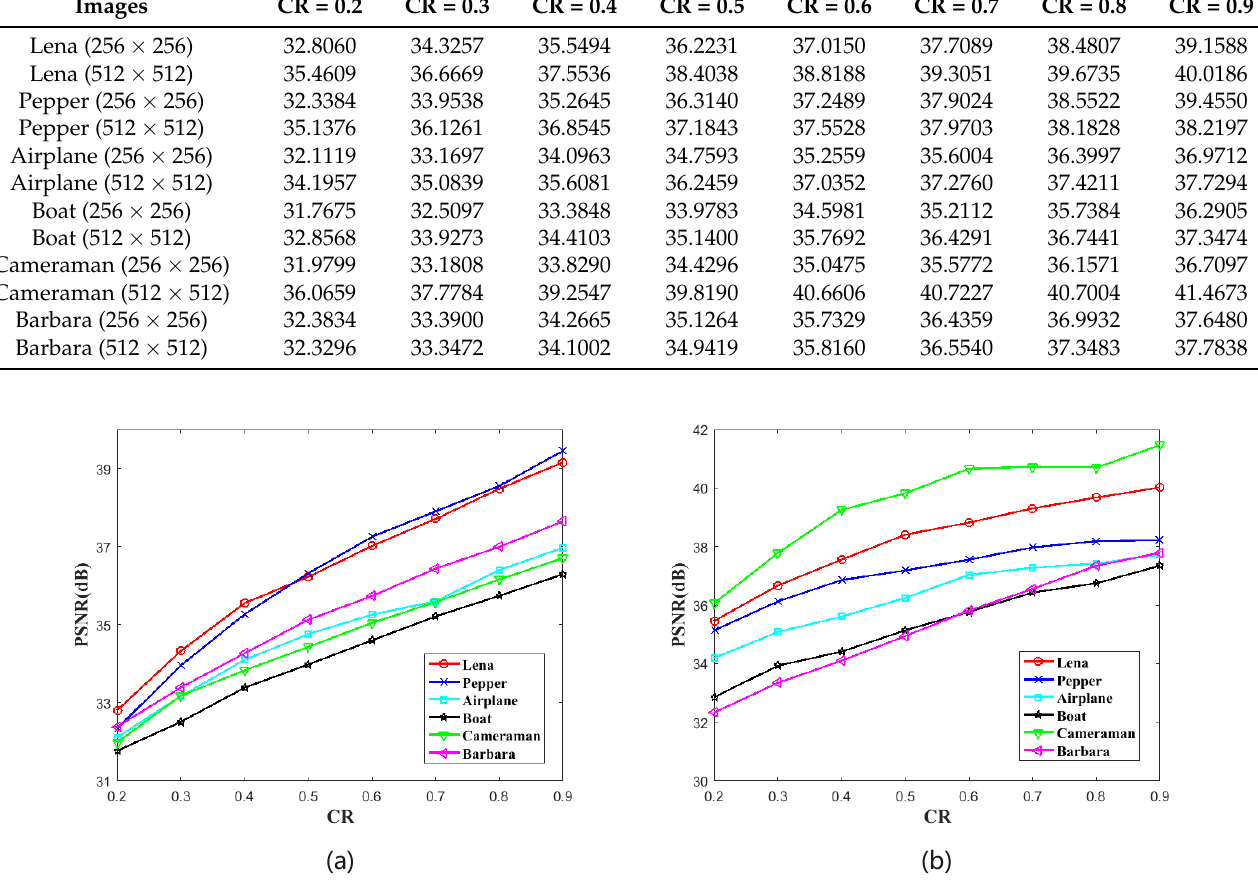
Figure 4. The Peak Signal to Noise Ratio (PSNR) test result. ( a ) shows the results of images with the size of 256 × 256. ( b ) shows the results of images with the size of 512 ×